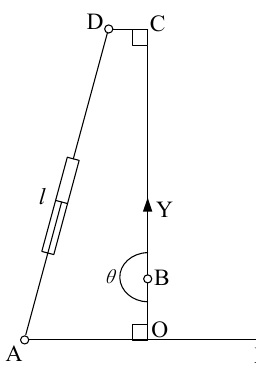
Figure 4. Schematic diagram of a four-bar linkage.